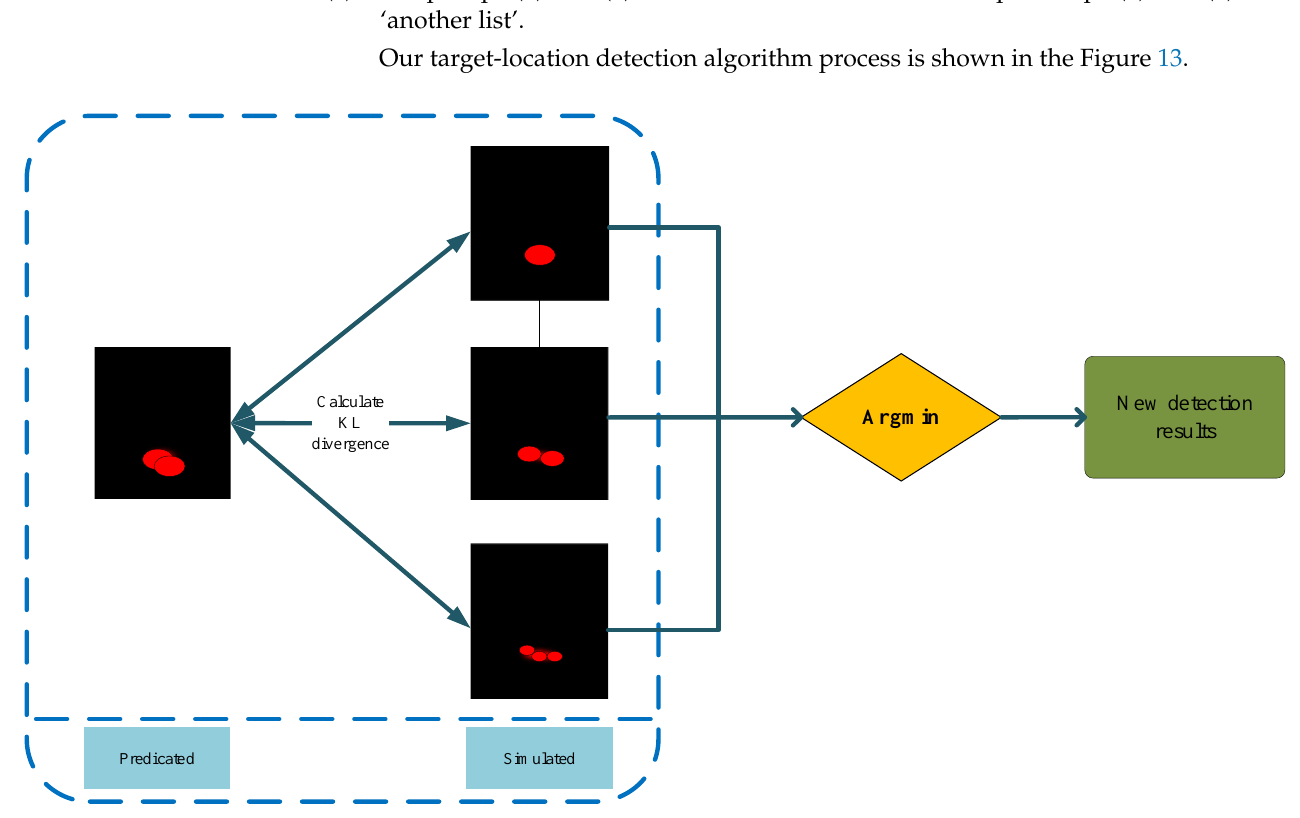
Figure 13. Flow chart of target number estimation method.